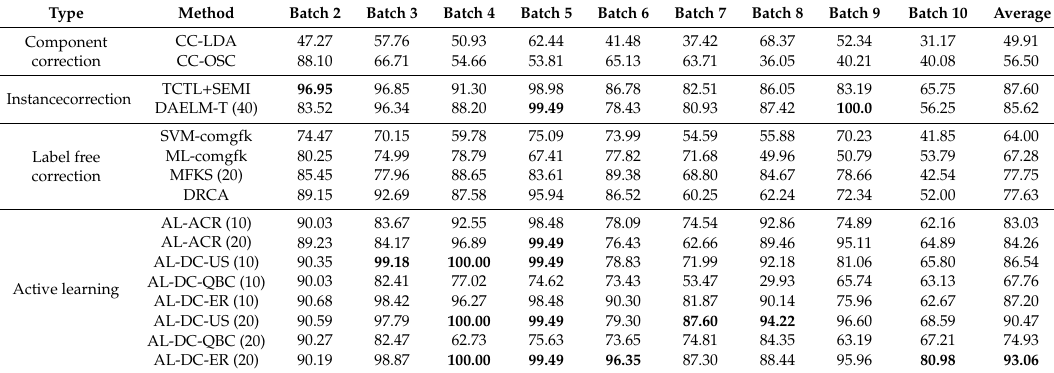
Table 3. Comparison of recognition accuracy in long-term drift